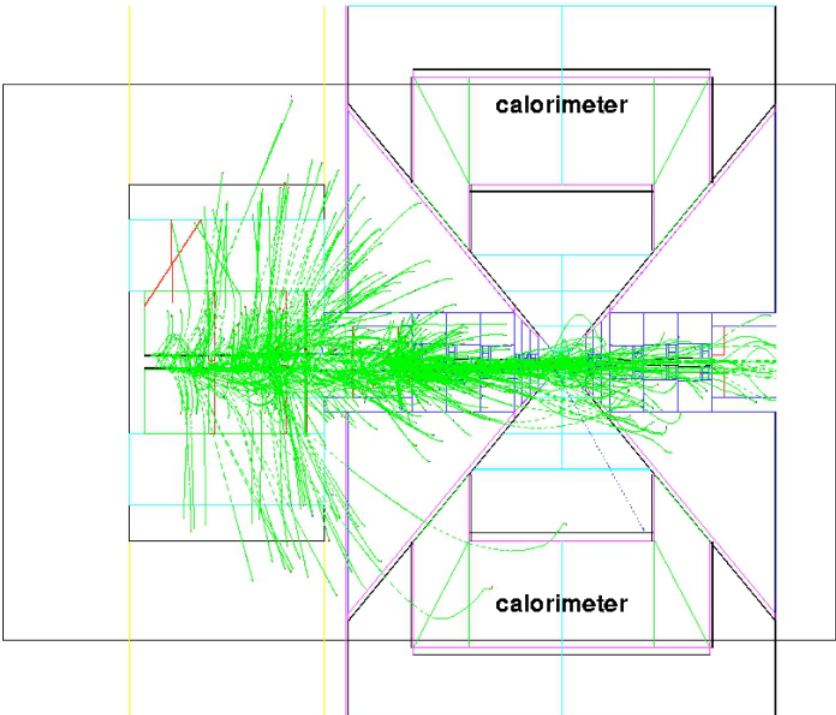
FIG. 68. (Color) Trajectories of typical Bethe-Heitler muons from their source in the shielding around the beam pipe to the detector for a 100 GeV COM collider. As indicated in the text the scale is extremely distorted, the total horizontal length is (cid:2) 20 m, and the outer edge of the calorimeter is (cid:2) 4 m. Notice that , 0.5% of the tracks end in the calorimeter (see Table XVII).